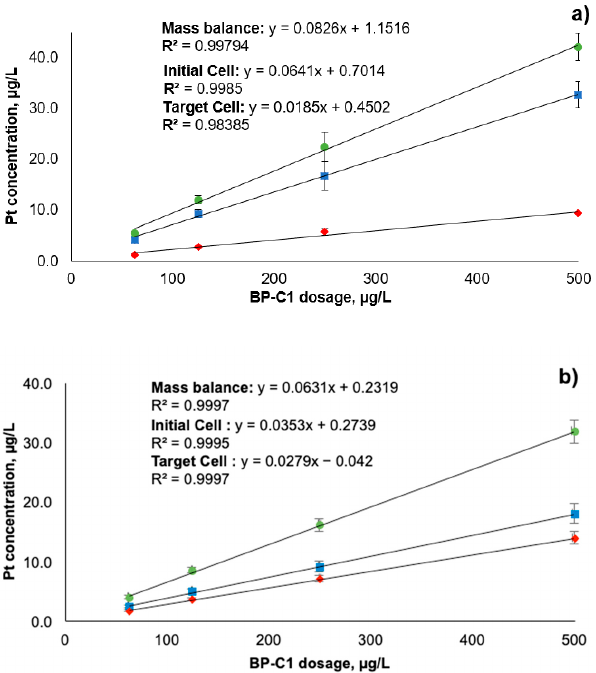
Figure 2. Dose dependence of the measured platinum (Pt) concentration in initial cell (retained fraction), target cell (dialysis fraction) and total Pt (mass balance in both cells) for: ( a ) 50% plasma and ( b ) control PBS dialysed against PBS with pH 7.2 for 4 h at 37 °C across the 8 kDa cut-off vertical membrane. Pt was quantified by ICP-MS after microwave digestion. Blue squares ( ) stand for initial cell after the establishment of equilibrium; red diamonds ( ) stand for target cell after crossing the dialysis membrane; green circles ( ● ) stand for total Pt in both cells (mass balance). Error bars represent ± standard deviation ( n = 6).